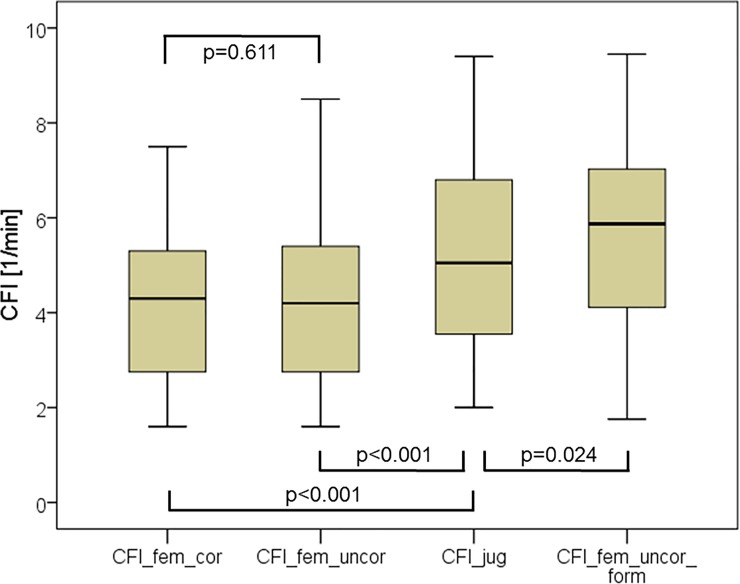
Boxplots plots comparing cardiac function index (CFI) derived from jugular indicator injection (CFI_jug), from femoral injection without activation of a potential correction by the device (CFI_fem_uncor), from femoral injection with activation of a potential correction by the device (CFI_fem_cor) and from femoral injection without activation of a potential correction by the device, but corrected by the previously suggested formula (CFI_fem_uncor_form).CFI_fem_uncor_form was corrected using the formula suggested for correction of femoral indicator injection derived GEDVI: GEDVIcorrected [ml/m2] = 0.539 * GEDVIuncorrected—15.17 + 24.49 * CIuncorrected 2.311* BWideal. CFI_fem_uncor_form was calculated by multiplying CFI_fem_uncor with the ratio GEDVuncorrected/GEDVcorrected. GEDV(I): global end-diastolic volume (index).